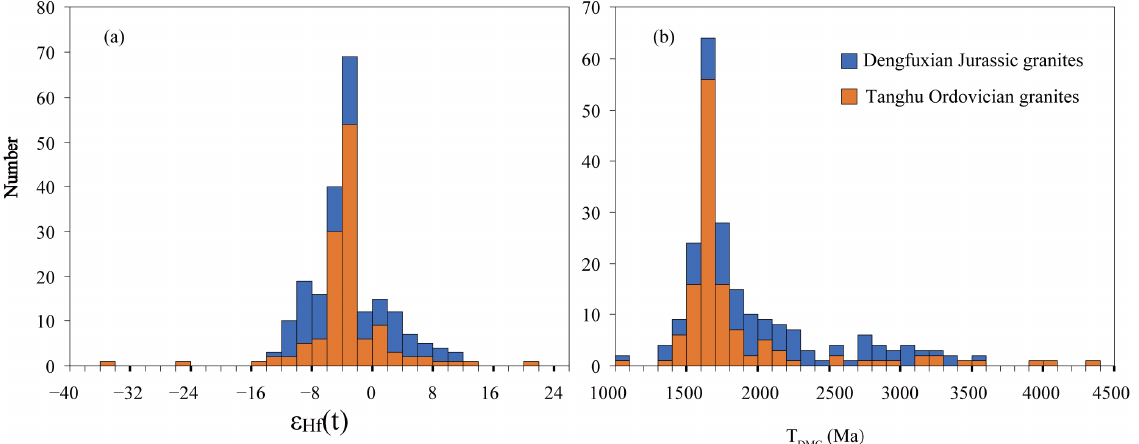
Figure 8. Histograms of zircon ε Hf (t) values ( a ) and Hf model ages (T DMC ) ( b ) for the Dengfuxian and Tanghu granites.